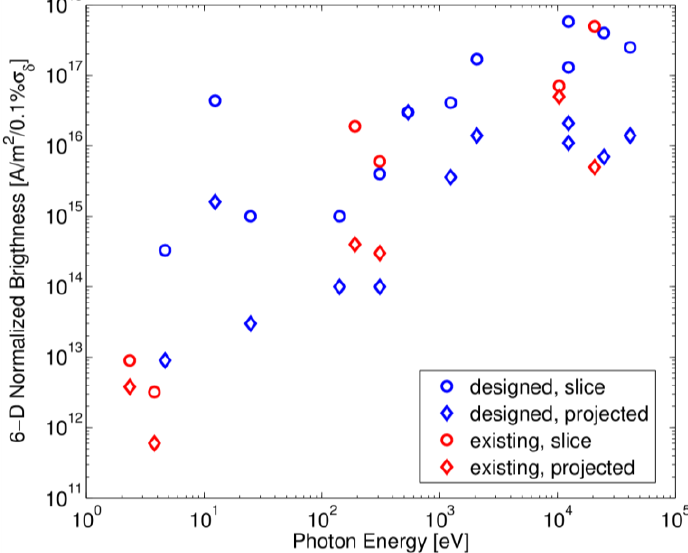
Figure 1. Six-dimensional normalized electron beam brightness vs. maximum photon energy at fundamental FEL emission, for facilities in the ultra-violet (UV) to X-rays, designed (blue) or running (red). Data taken from [49] and updated to 2013. From lower to higher energies, now-running facilities are: SPARC (Italy), SDUV-FEL (China), FLASH-I (Germany), FERMI (Italy), LCLS (USA), SACLA (Japan). The brightness refers to the projected (circle) or slice value in the bunch